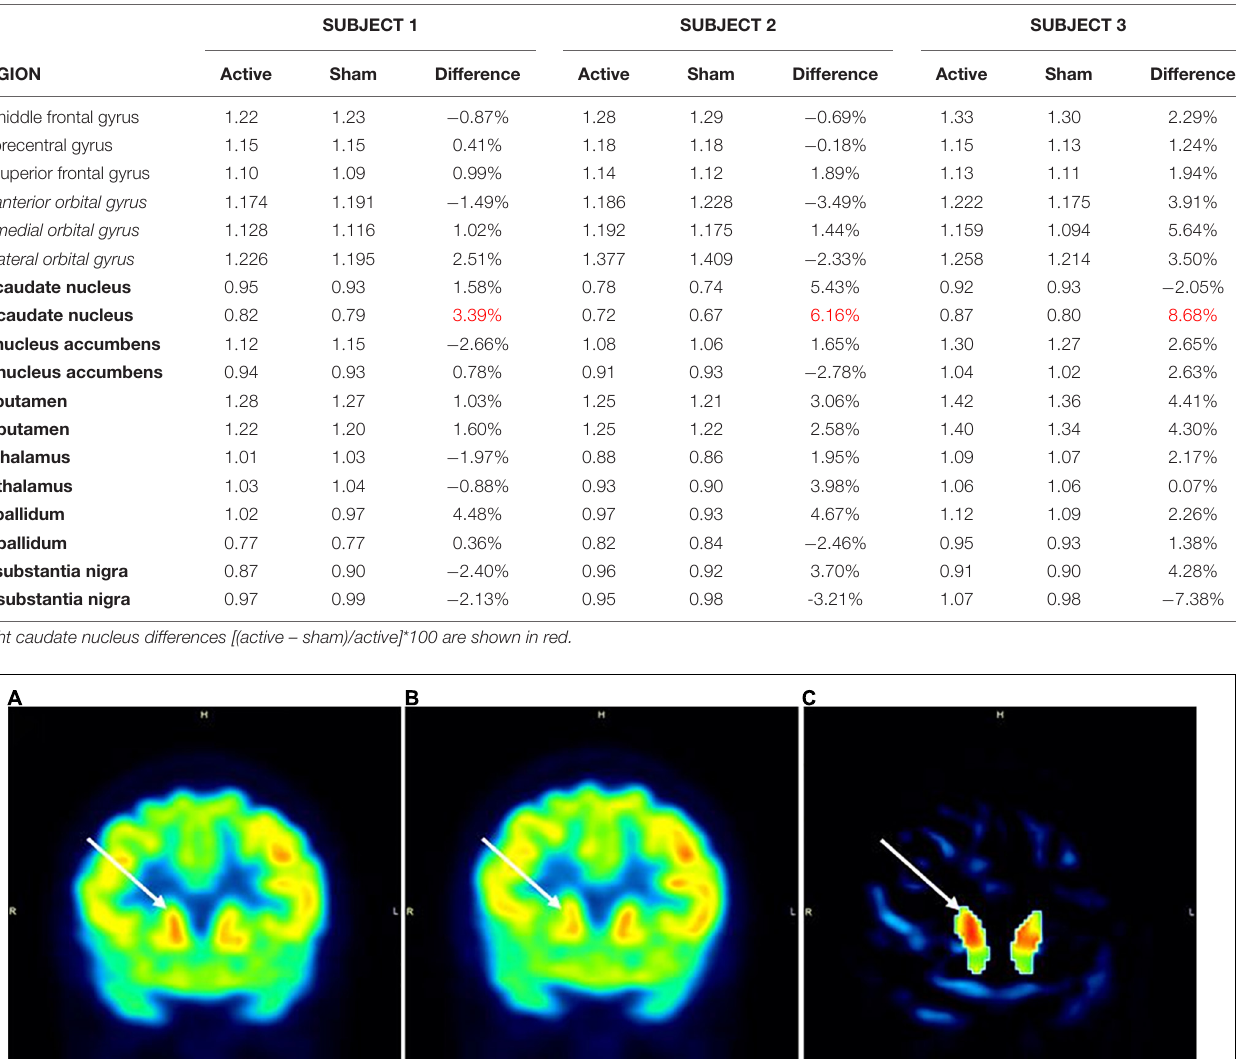
TABLE 1 | Relative regional metabolism in motor areas beneath the anode, cathode and the basal ganglia.